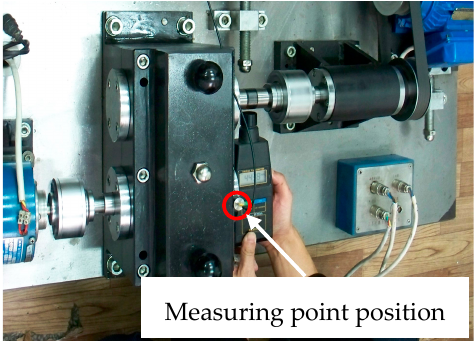
Figure 12. Comprehensive fault diagnosis experimental platform.